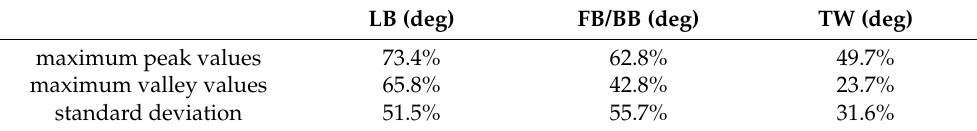
Table 6. Improvement percentage session 1–session